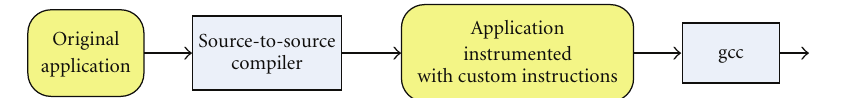
Figure 14: modified toolchain to include the source to source compiler that produces the custom instructions that generate function